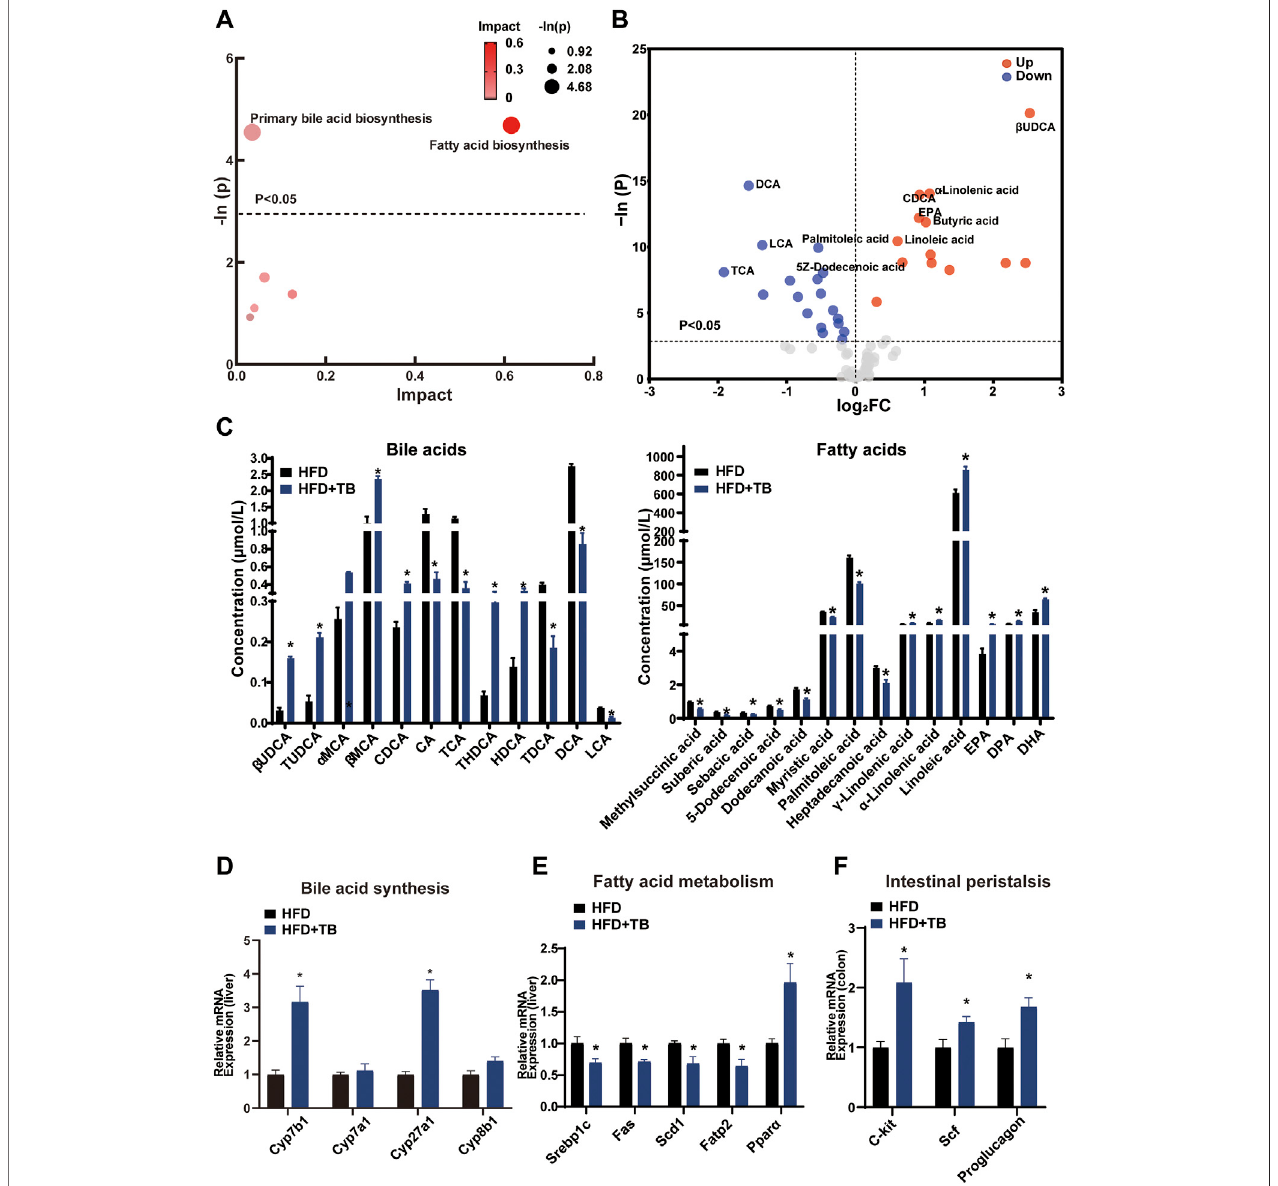
FIGURE3|(A) Bubblechartofpotentialsignalingpathways.PathwayanalysiswasperformedintheKEGGdatabase.Thecolorandsizeofeachbubblerepresent the impact of metabolites in each pathway and p value, respectively. (B) Volcano plot for the differential metabolites (HFD + TB group vs. HFD group). Metabolites with statisticallydifferentiallevelslieabovethehorizontalthreshold line.Metaboliteswithlarge foldchangevaluesliefarfromtheverticalthresholdlineatlog2-foldchange=0, indicating whether the metabolite is up or downregulated. (C) The concentrations of differential serum metabolites. (D) The mRNA expression of hepatic BA synthetic genes. (E) The mRNA expression of hepatic fatty acid metabolism-related genes. (F) The mRNA expression of intestinal peristalsis-related genes. n = 8 individuals/group. Data were expressed as mean ± SEM. Differences between data were assessed by the Mann – Whitney U test; * p < 0.05 compared with the HFD